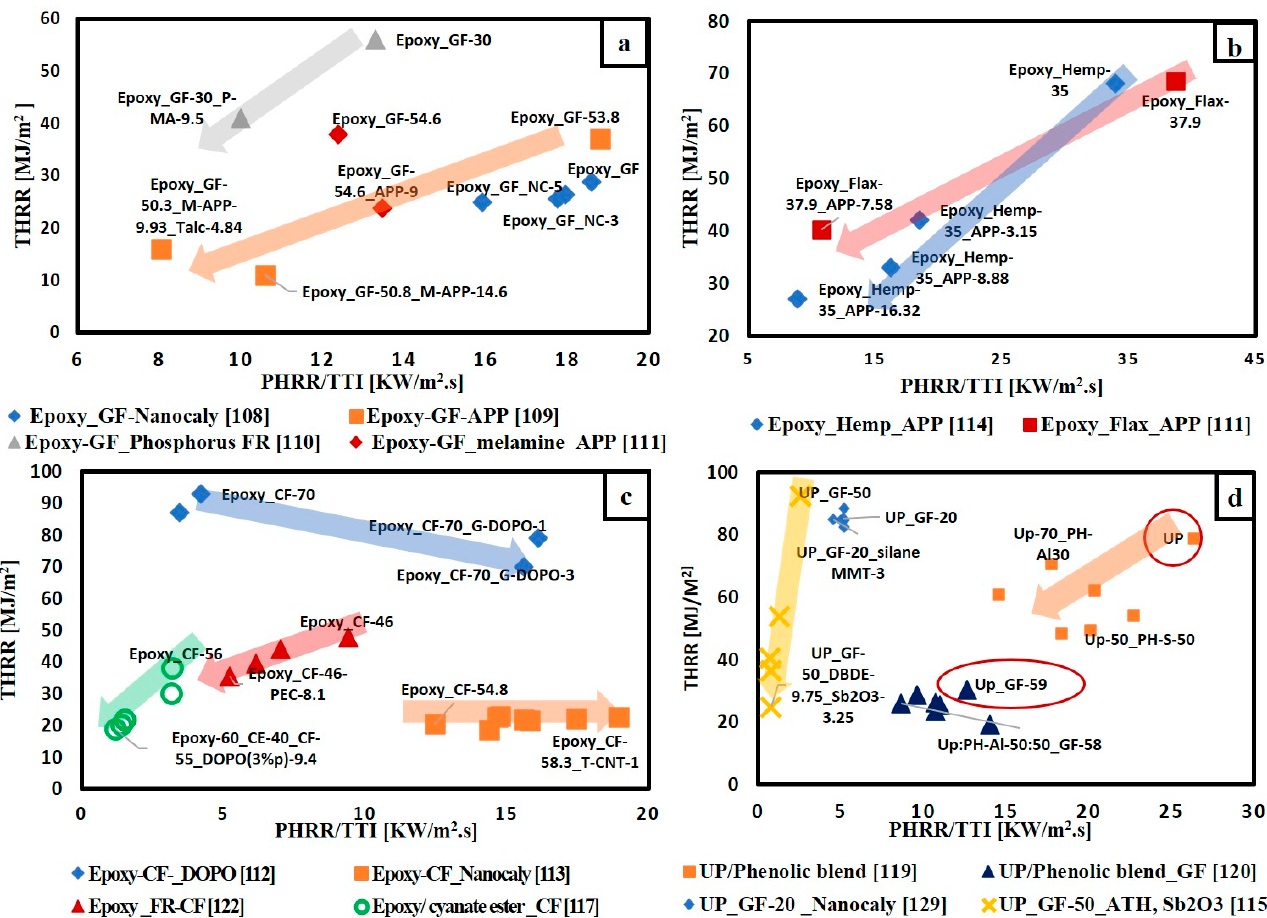
Figure 10. THRR versus PHRR/TTI for different composites ( a ) FR/epoxy reinforced glass fabric; ( b ) FR/epoxy reinforced natural fibre-fabrics; ( c ) FR/epoxy reinforced carbon fibre-fabrics; ( d ) FR/unsaturated polyester reinforced glass fibre-fab- ric.